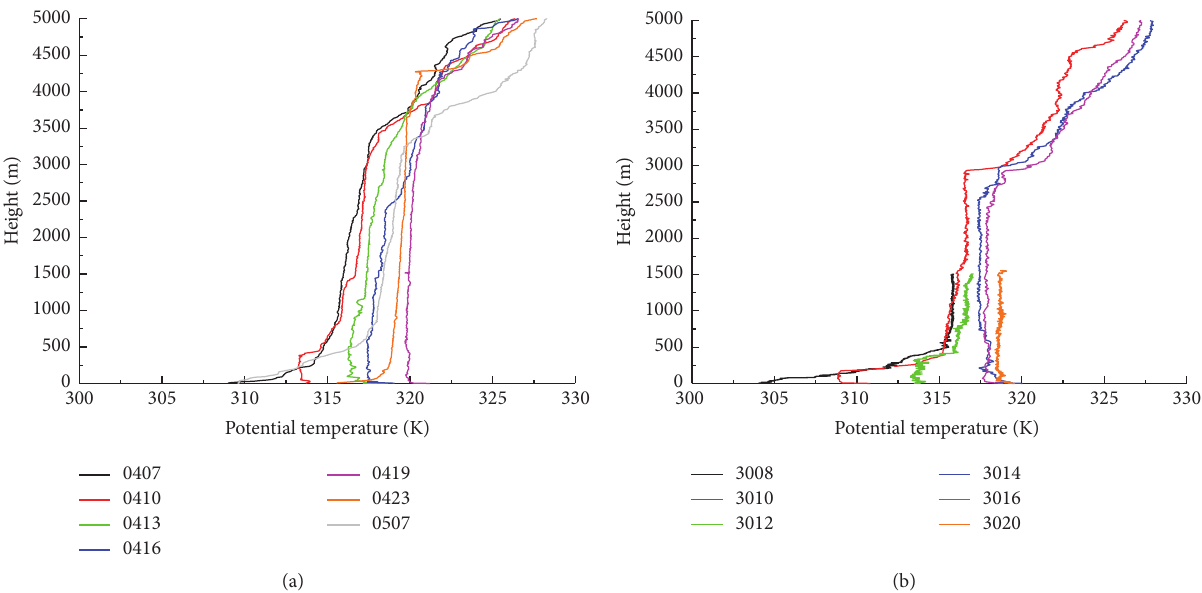
Figure 3: Comparison of potential temperature profile on (a) July 4, 2012, and (b) August 30, 2009. The observation time (UTC) of each profile is showed in the